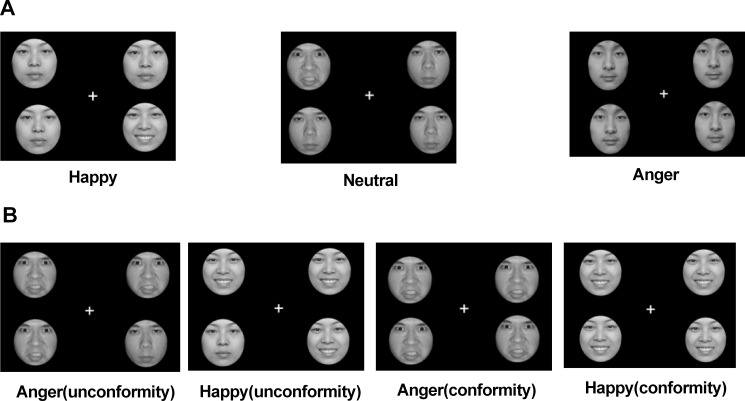
Emotional search task.(A) Representative images from the attentional facilitation task. (B) Representative images from the attentional disengagement task.